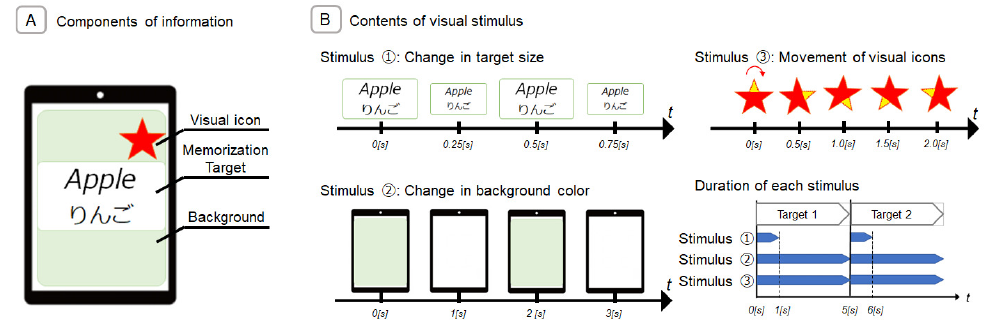
Figure 2. ( A ) Information screen design. ( B ) visual stimulus